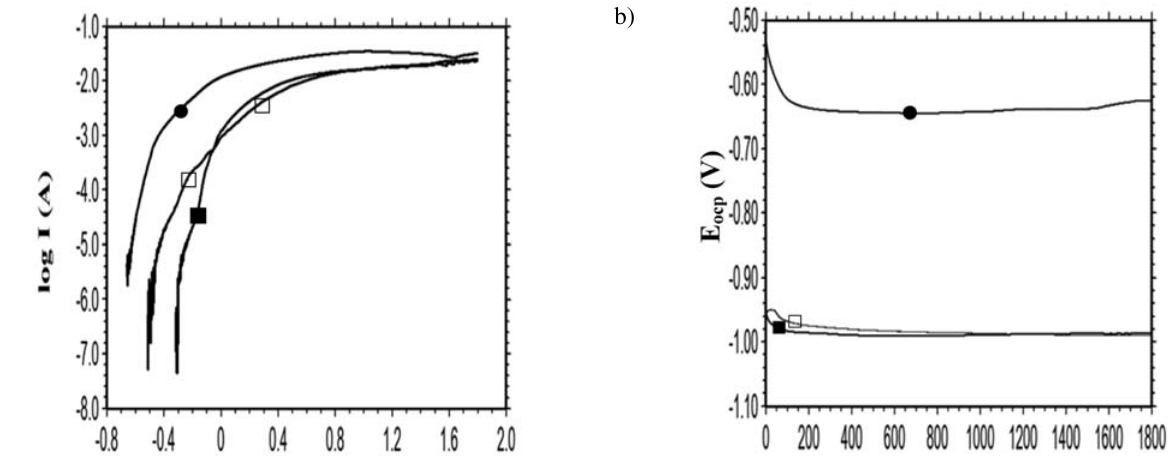
Fig. 4. The anodic polarization (a) and E solution.